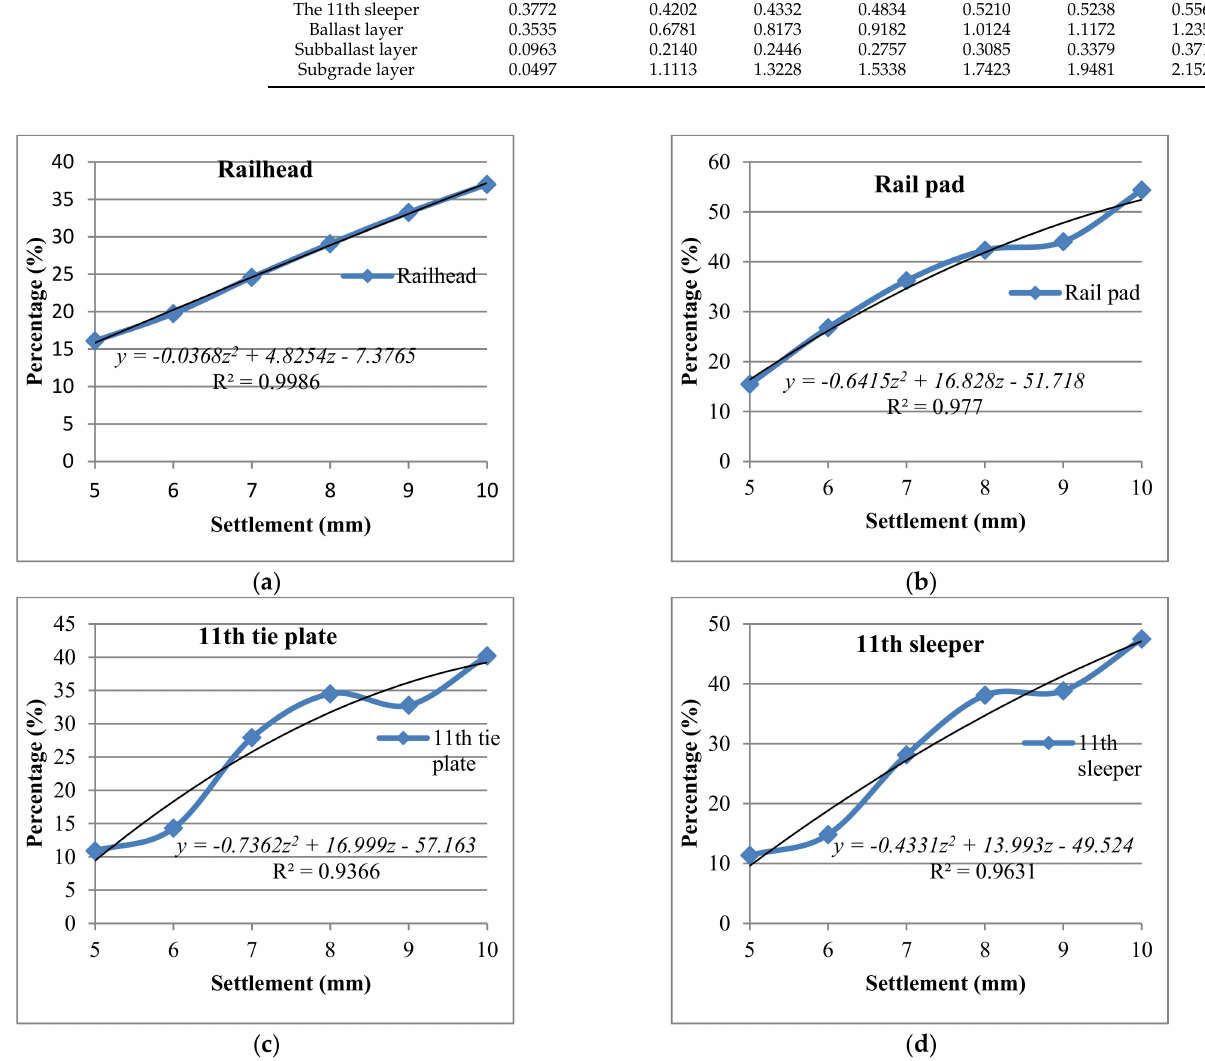
Figure 19. Rate of additional stresses in different elements of the track model: ( a ) railhead; ( b ) the 11th rail pad; ( c ) the 11th tie plate; ( d ) the 11th